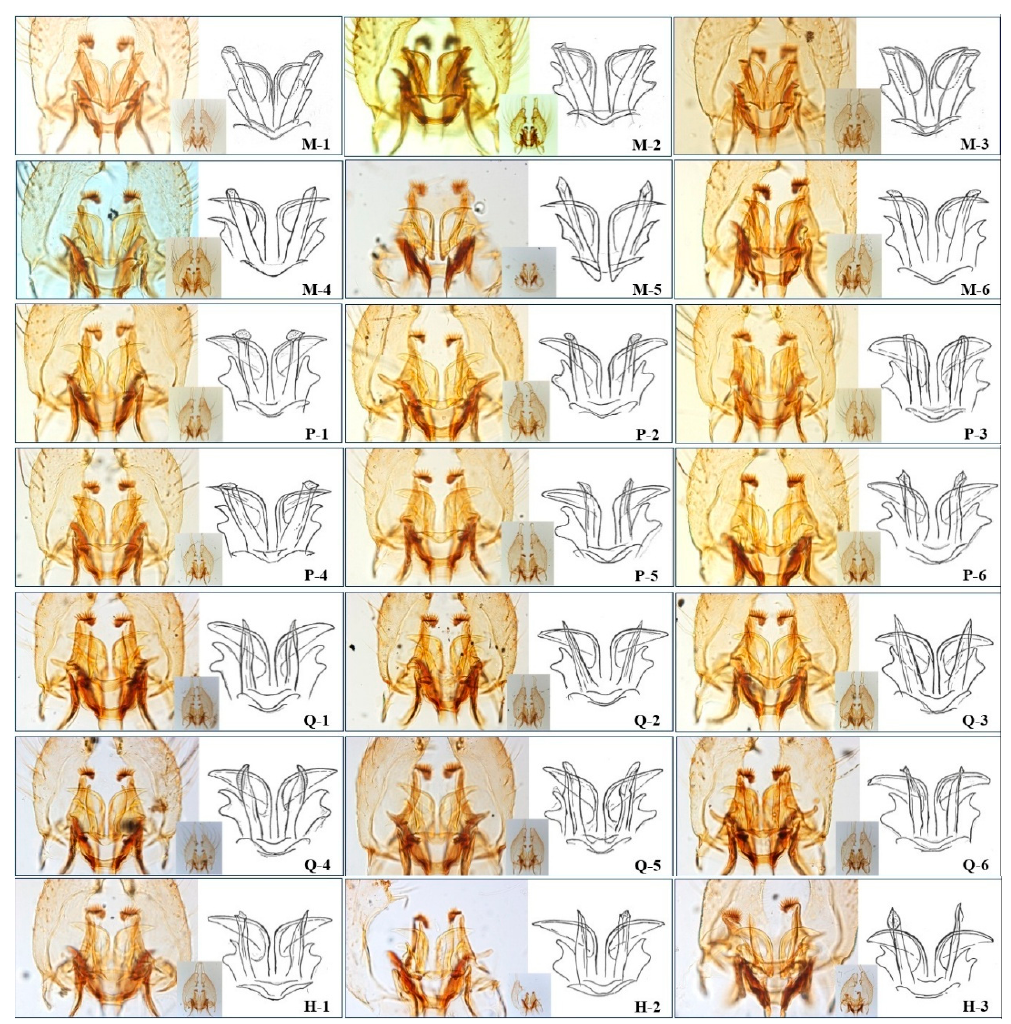
Figure 3. Genitalia (dorsal view, post-rotation) of male Culex pipiens complex samples collected in downtown Shanghai, China. Typical C. p. molestus (M-1, 2, 3): the dorsal arms are divergent and broad, and their tips are thick and blunt, the ventral arms are narrow, short and sharply bent laterally. Atypical C. p. molestus (M-4, 5, 6): the ventral arms are longer than the typical ones, and the DV/D ratio increases accordingly. Typical C. p. pallens (P-1, 2, 3): the dorsal arms are divergent and broad, and their tips are thick and bluntly round (or truncate), the ventral arms are broad, long and extend caudolaterally (the same as C. p. quinquefasciatus ). Atypical C. p. pallens (P-4, 5, 6): the ventral arms are narrower (P-4), or the cross-section of the dorsal arms’ tips are irregular (P-5, 6). Typical C. p. quinquefasciatus (Q-1, 2, 3): the dorsal arms are parallel (or divergent, Q-2, 3) and narrow, and their tips are markedly pointed, the ventral arms are broad, long and extend caudolaterally. Atypical C. p. quinquefasciatus (P-4, 5, 6): the tips of the dorsal arms are “thumb-shaped” (Q-4), or the dorsal arms are a little bit thicker (Q-5) or flat (Q-6). Hybrids of pallens and quinquefasciatus (H-1, 2, 3): morphological character of the dorsal arms is between C. p. pallens and C. p. quinquefasciatus .